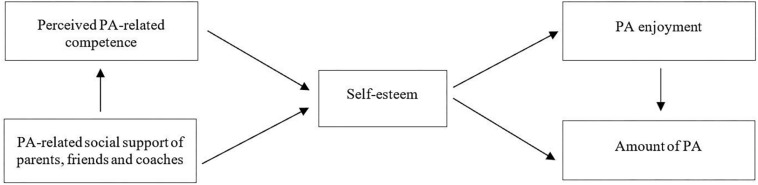
Development model of PA (Weiss, 2000).